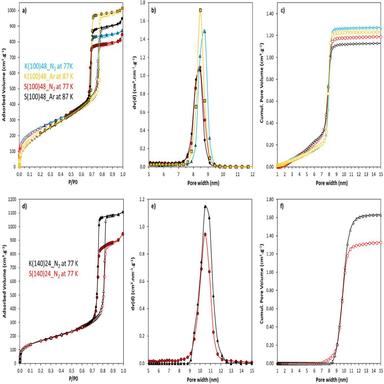
Ar at 186 C and N2 at 196 C physisorption isotherms (a, d), corresponding NLDFT desorption pore size distributions (b, e) and NLDFT cumulative pore volume curves, calculated from the adsorption branches (c, f) of S(100)48, K(100)48, S(140)24 and K(140)24, as indicated.